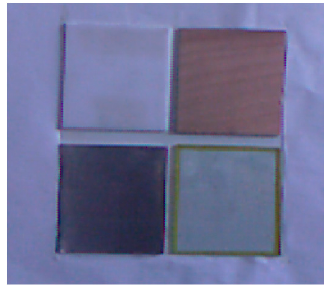
Figure 6. Four boards made of different materials.